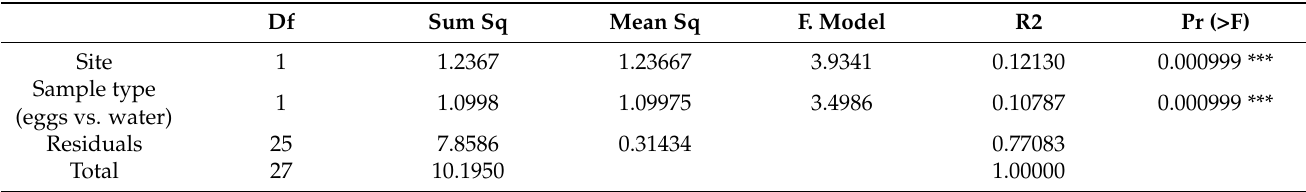
Table 2. PERMANOVA analysis (nr. of permutations = 1000) across all egg and water samples based on two factors: aquaculture site (Site 1, Site 2, and Site 3) and type of sample (egg vs. water).